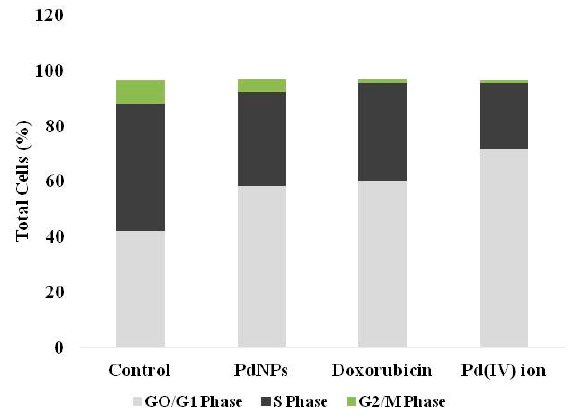
Figure 8. Cell cycle analysis of SKOV3 cells exposed to PdNPs, doxorubicin and Pd(IV) ion. The cells were treated with 2.5 µg/mL of PdNPs, doxorubicin, and Pd(IV) ion and for comparison, an equal volume of vehicle was used in parallel cultures. The proportion of cells in the different phases was quantitated and represented with partitioned bars as the average of three experiments. G0/G1-phase: light grey; S-phase: dark grey; G2/M phase: green. Table 2. Cell cycle distribution data of SKOV3 cells exposed to PdNPs, or doxorubicin or Pd(IV) ion. Phase